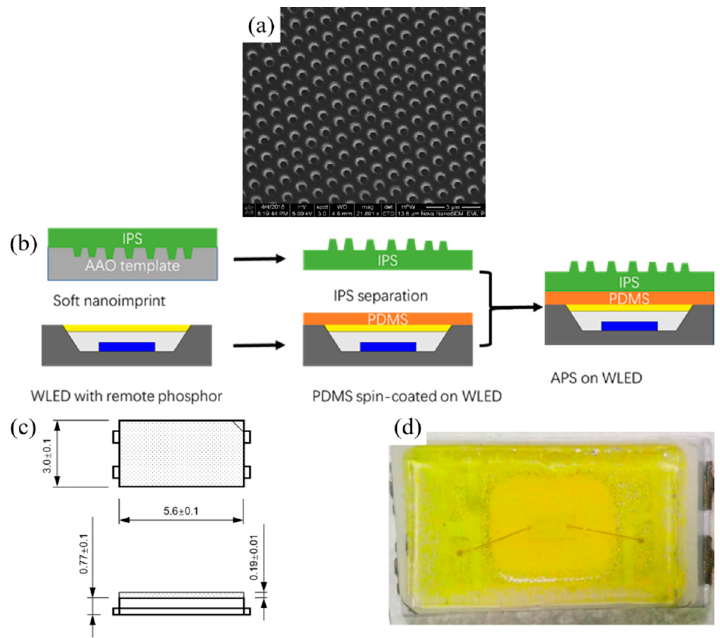
Figure 1. ( a ) SEM images of typical APS imprinted using AAO template. ( b ) The schematic diagram of APS transferring and surface-mounting process. ( c ) The schematic diagram and feature size of the white LED with and without package. ( d ) The top-view photo of the completed device.